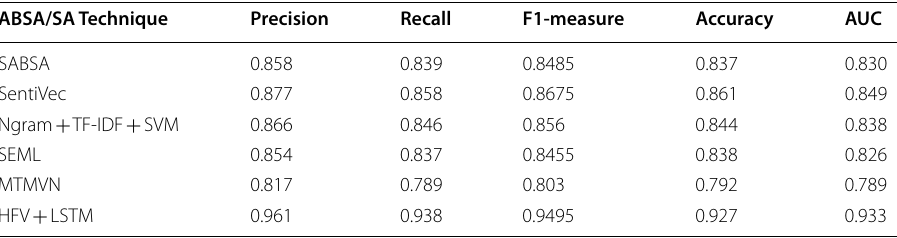
LSTM Model using Sentiment140 data set with State-of-the-Art +